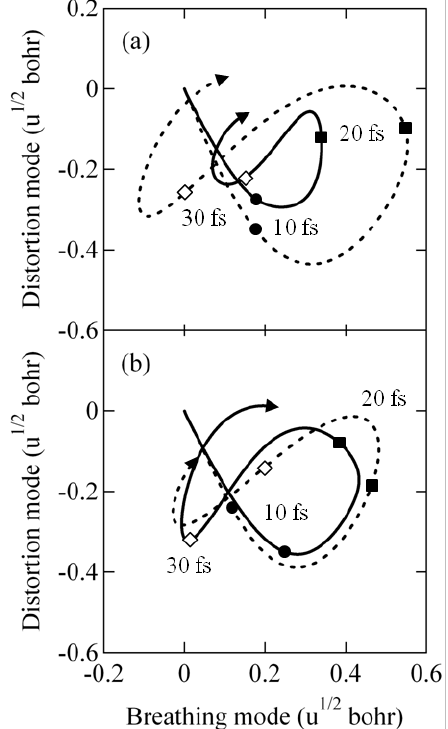
Figure 6. Expectation value of the normal coordinates Q ( t ) of the breathing and distortion modes in DCP irradiated by ( a ) linearly and ( b ) circularly polarized VUV laser pulses. In panel ( a ), the expectation values for e (+) and e (−) are denoted by the solid and dotted lines, respectively; in panel ( b ), those for e +1 and e − 1 are denoted by the solid and dotted lines, respectively. The laser pulses fully decay at t = 7.26 fs. Reprinted from [56] with permission of the American Chemical Society.